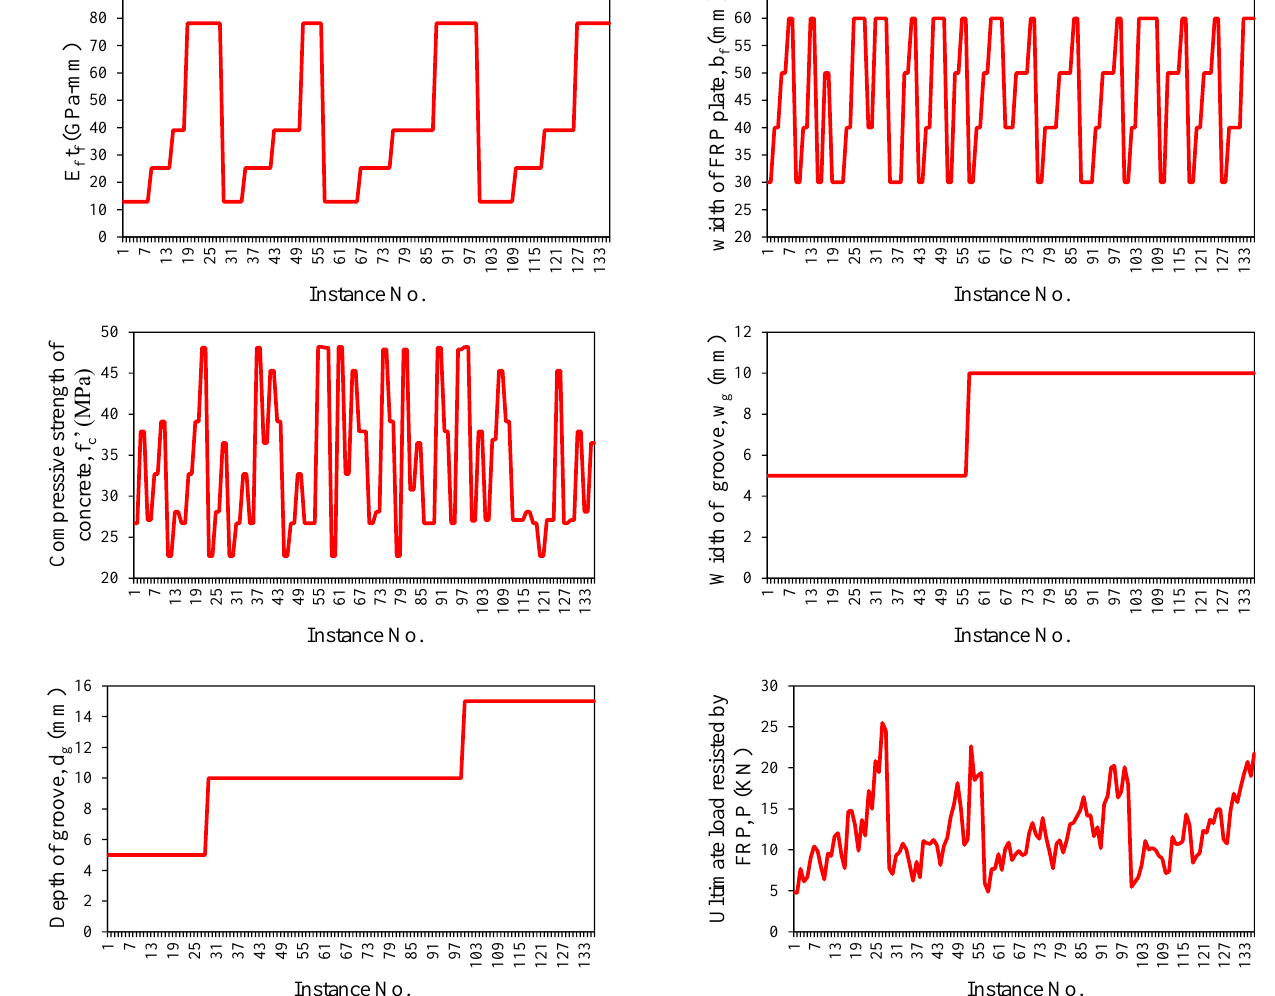
Figure 2. Details of variables used in the development of models.